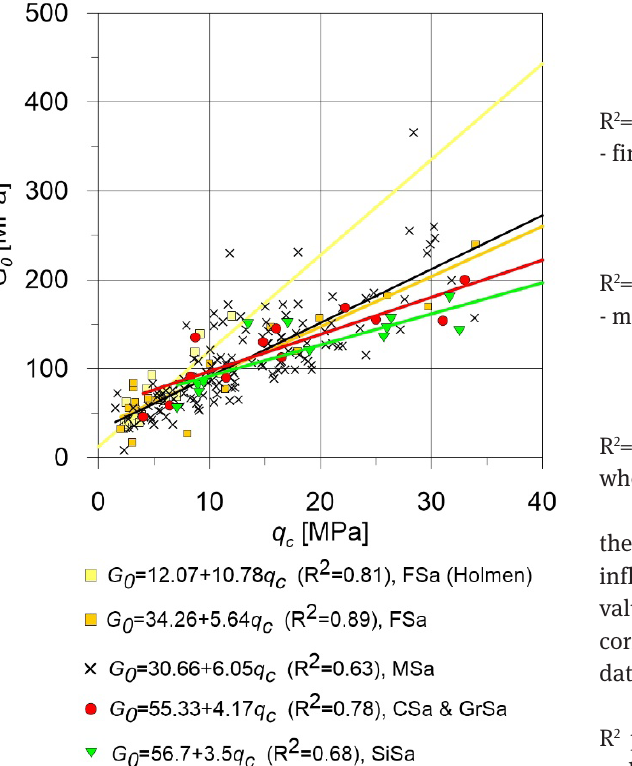
Figure 10: The correlation between modulus G q for overconsolidated soils taking into account the type of c